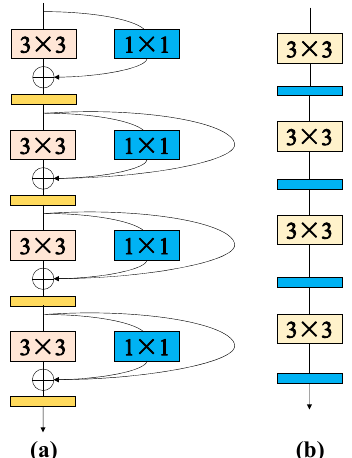
Figure 3. Schematic diagram of the partial structure of RepVGG. ( a ) RepVGG training. ( b ) RepVGG inference.